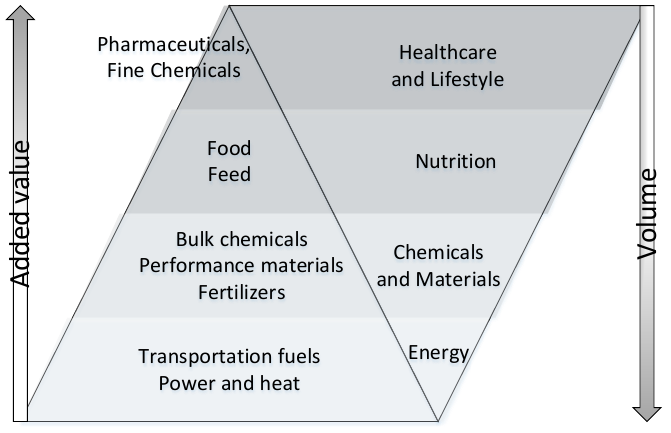
Fig. 2. The pyramid of value added in bioeconomy